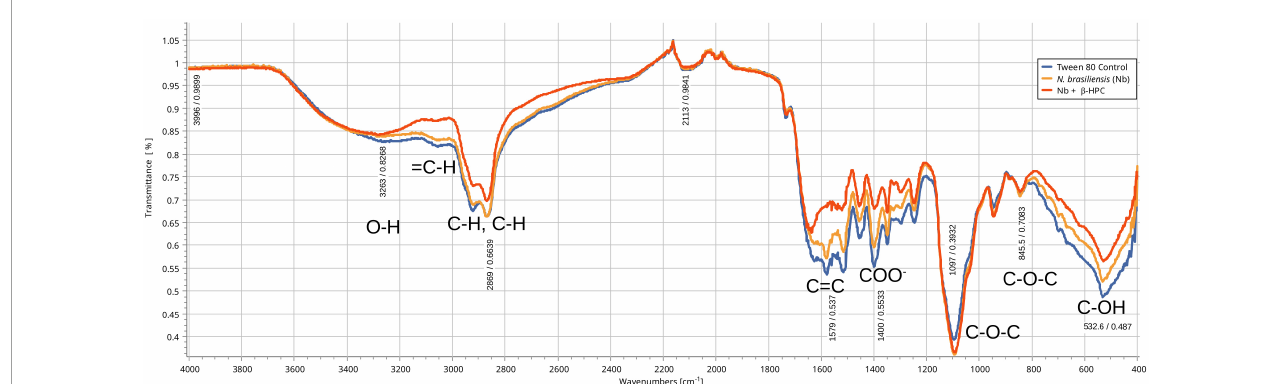
FIGURE4 Comparison of FT-IR spectra of the hydrolytic activity of N. brasiliensis on tween 80 with and without β -HFC. Culture medium (control blue line), hydrolyzate of 7 days of N. brasiliensis growth (orange line), hydrolyzate of growth of 7 days of N. brasiliensis + β -HPC (red line). A decrease in the alcohol group (O–H) is observed, as well as the signals of alkenes (= C-H), alkanes (C–H), and carboxylic acids (COO). In contrast, more intense signals are detected mainly from ethers (C–O–C), both groups of signals, when accumulating and intensifying the signal, also indicate an increase in the utilization of Tween 80 when N. brasiliensis + β -HPC is incubated.